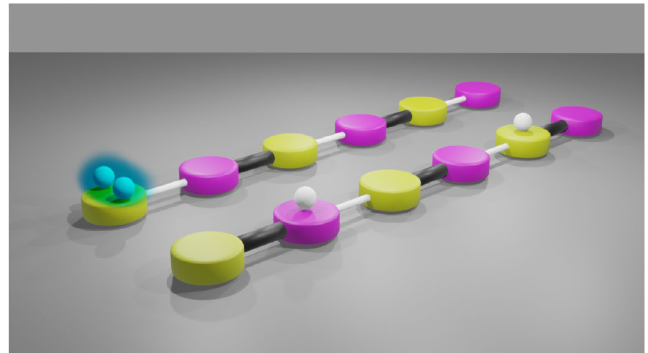
Figure 1. Sketches of dimerized chains of oscillators, each of resonance frequency ω 0 , and represented by yellow and pink disks. The alternating coupling strengths J 1 and J 2 are denoted by thin white and thick black rods. The setup mimics the two-particle Bose–Hubbard version of the celebrated Su-Schrieffer-Heeger topological model. The two excitations are depicted by two white balls, and are subject to the on-site interaction U . Left chain: in the nearest edge oscillator there is a doublon (illustrated by the blue cloud) of two bound excitations on the same oscillator. Right chain: the two excitations are separated, and may be found in the bulk of the chain on the second and fifth oscillators respectively. Figure credit: S. Martínez Azcona